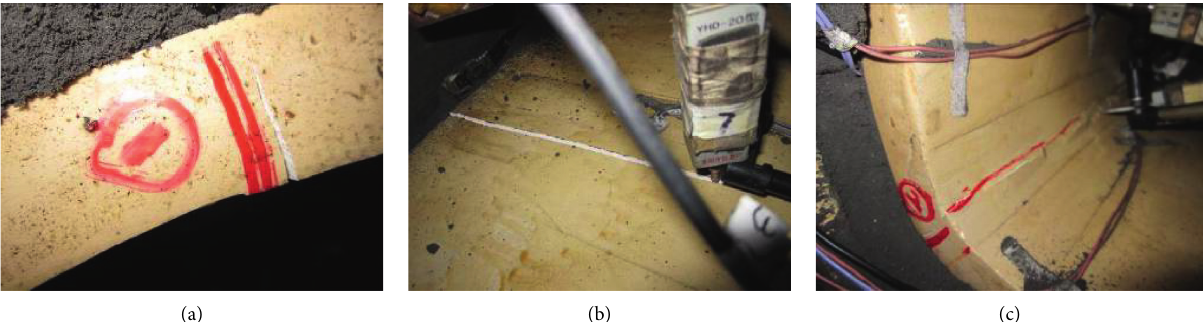
Figure 8: Lining cracks of the plain concrete. (a) The first crack (vault). (b) The second crack (inverted arch). (c) The third crack (left side wall feet).